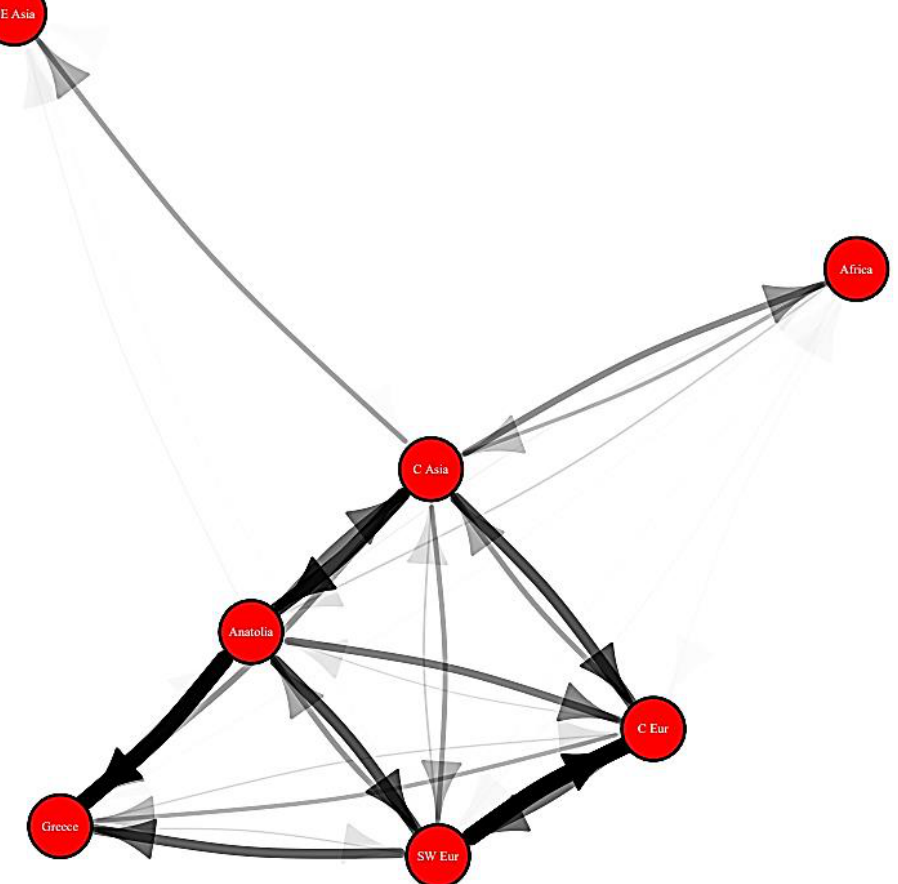
Figure 2. Map of reconstructed immigration and emigration rates for Old World Miocene muroids (work in prep.) based on a DEC analysis run using BioGeoBears in R. Arrows represent reconstructed movement of an individual lineage from one region to another. Arrows are shaded to represent the frequency of a specific transition.